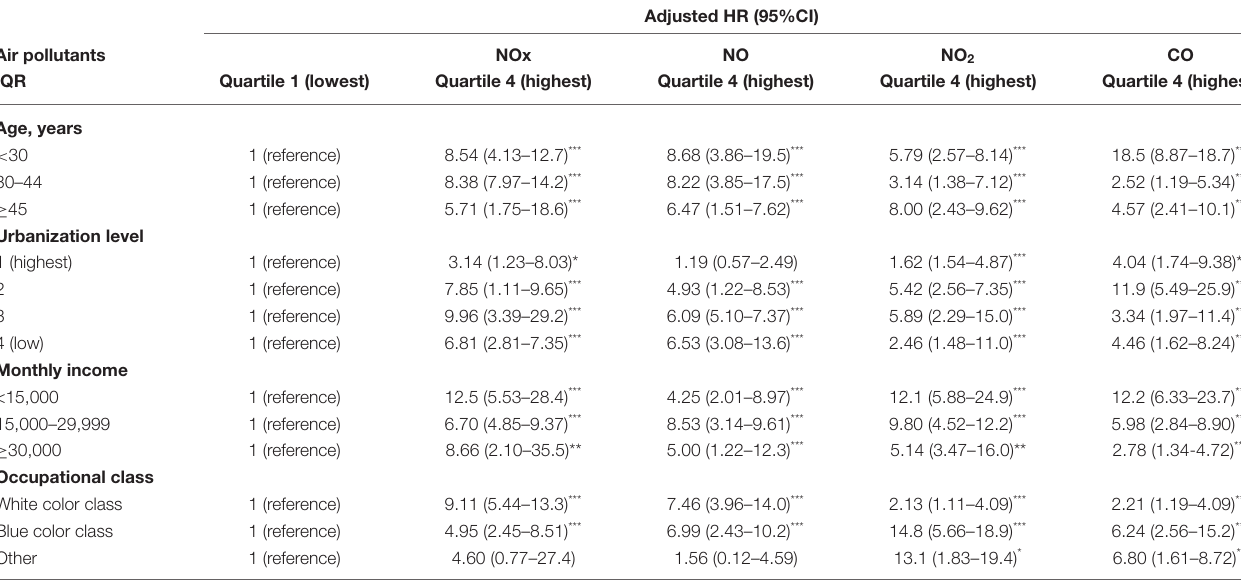
TABLE 4 | Incidence rate and hazard ratio of pre-eclampsia and eclampsia between various daily average concentrations of NOx, NO, NO 2 , PM 2.5 , and CO stratified by gender, age, and comorbidities.